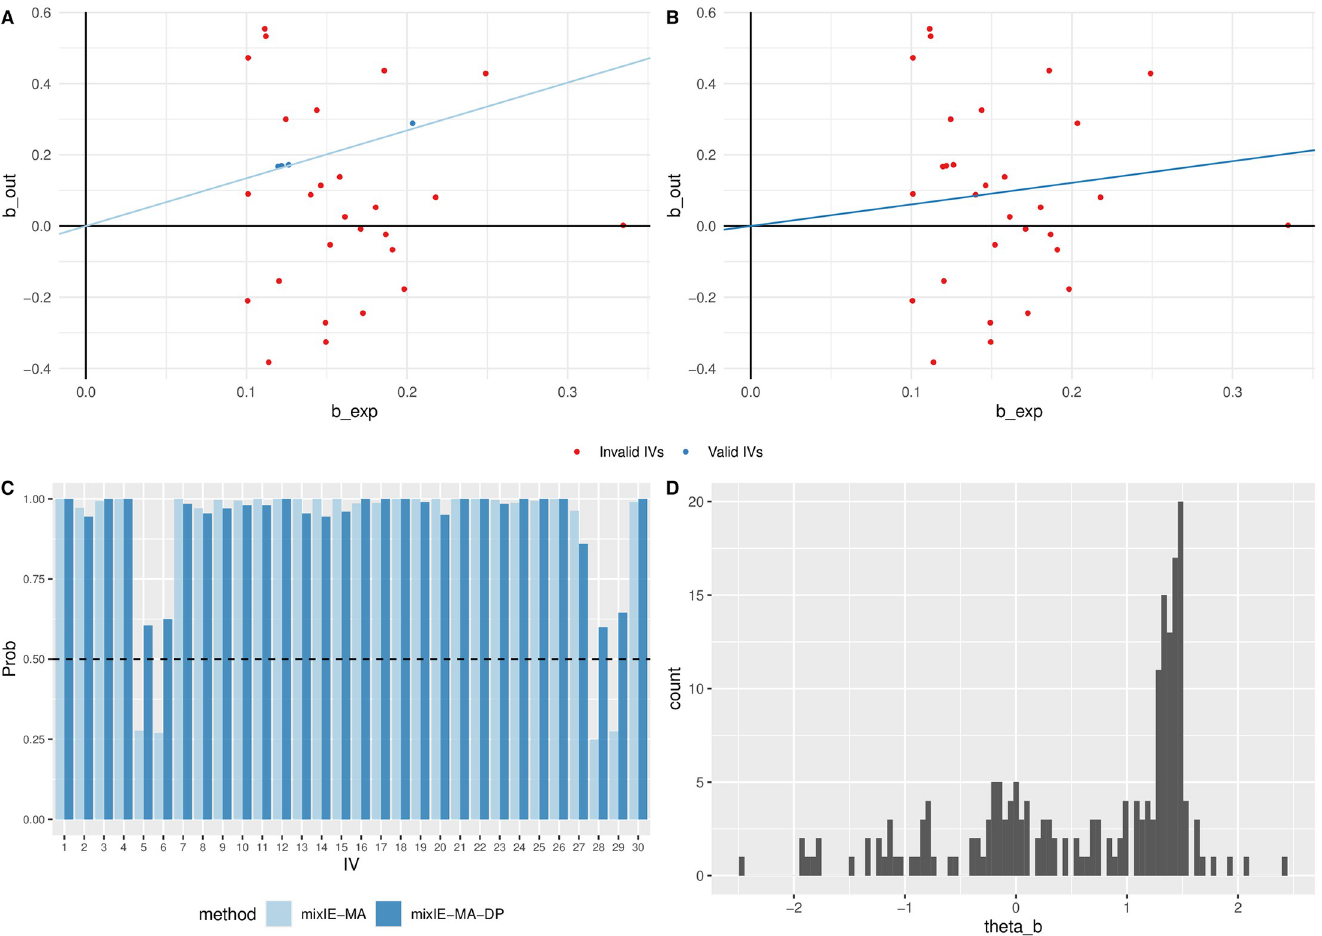
Fig 5. A simulated data example with n = 50 000, m = 30, θ = 0, p_invalid = 1 under directional pleiotropy and InSIDE satisfied. A: Causal estimate and identified invalid IVs by mixIE-MA. B: Causal estimate and identified invalid IVs by mixIE-MA-DP. C: Posterior probability of each IV being invalid. D: Histogram of ^ y ð b Þ� from 200 perturbations.